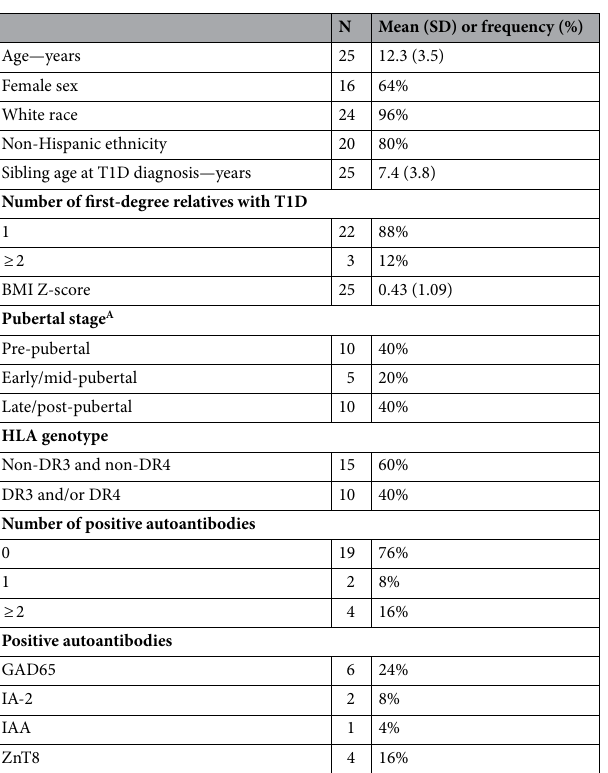
Table 1. Baseline characteristics of the 25 participants. Pre-pubertal is defined as Tanner stage 1; mid-pubertal is defined as Tanner stage 2–3; late/post-pubertal is defined as Tanner stage 4–5. A Pubertal staging was performed by a pediatric